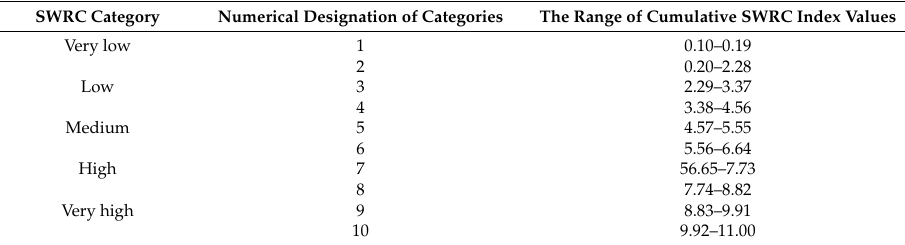
Table 1. Categories of cumulative soil water retention capacity (SWRC) index values.